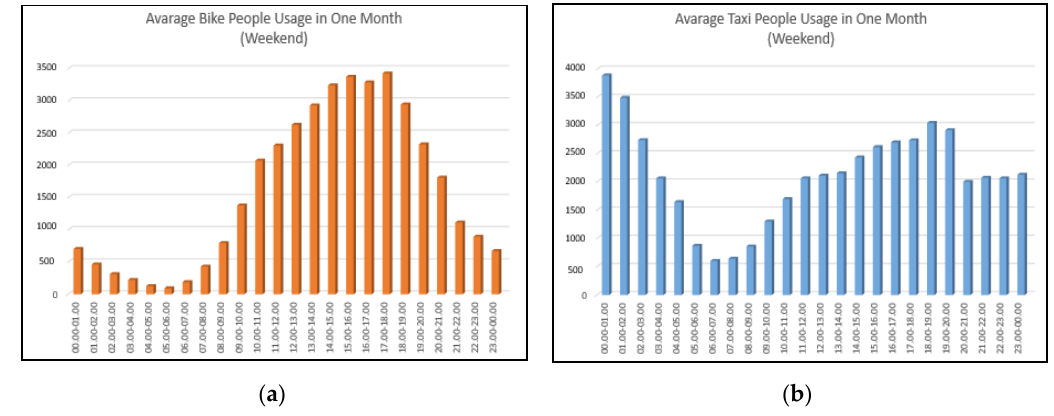
Figure 5 . Average usage on weekends in one month: ( a ) bike; ( b ) taxi. Figure 5. Average usage on weekends in one month: ( a ) bike; ( b ) taxi.